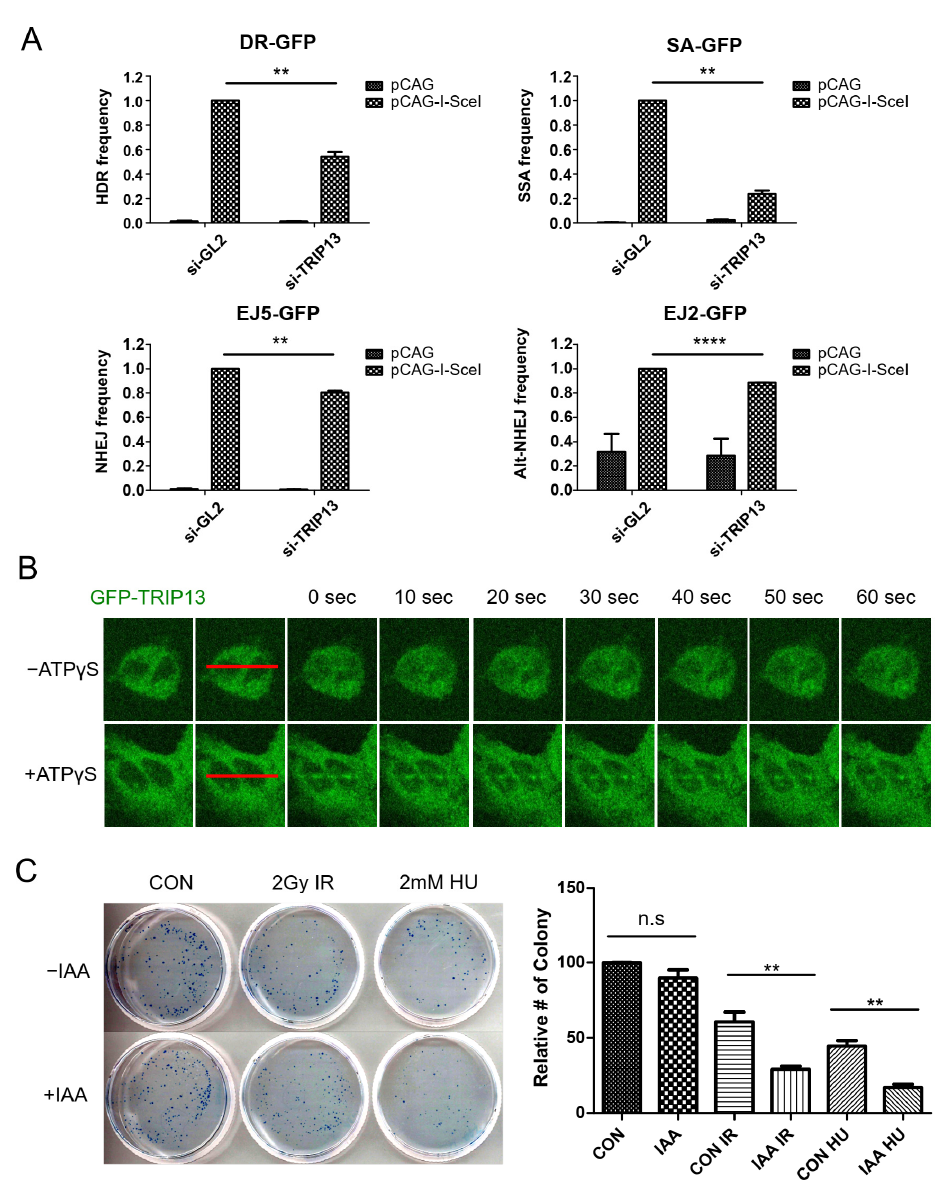
Figure 1. TRIP13 is required for DSB repair. ( A ) I- Sce I-based GFP-reporter assays were performed to measure the contributions of mammalian chromosomal double-strand break repair pathways upon TRIP13 knockdown. TRIP13 knockdown selectively inhibited the HDR and SSA pathways but not NHEJ. DR-GFP, SA-GFP, EJ5-GFP, and EJ2-GFP were used to measure HDR, SSA, classical NHEJ, and alt-NHEJ, respectively [22]. ( B ) GFP-labeled TRIP13 was rapidly recruited to DNA damage sites induced by UV laser microirradiation. ( C ) A colony formation assay confirmed that IAA-induced degradation of TRIP13 affected cellular responses to DNA damage induced by IR or HU treatment. The two-tailed unpaired T-test was performed to determine significance (n.s: not significant; ** p < 0.01; **** p < 0.0001).